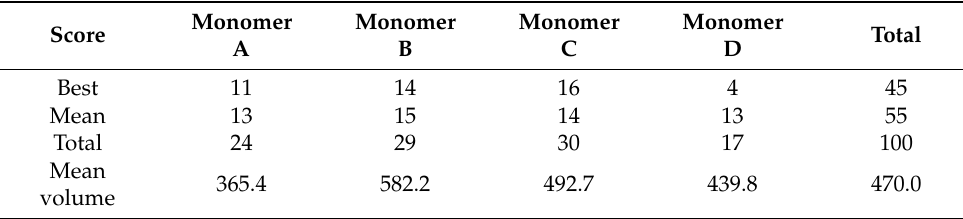
Table 2. Frequency of the scores from the four simulated non-optimized monomers in the selected consensus equations. The table also includes the mean volumes of the four binding sites in the 50 selected frames (in Å 3